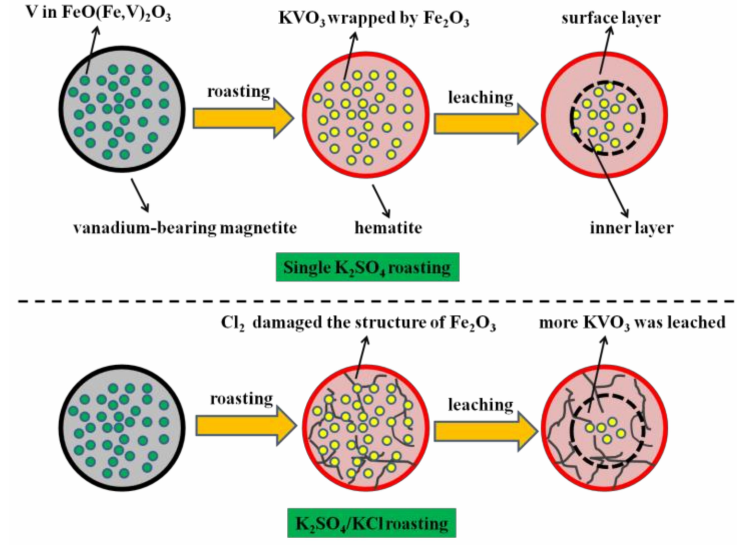
Figure 9. Mechanism schematic of K 2 SO 4 /KCl for strengthening vanadium extraction from the